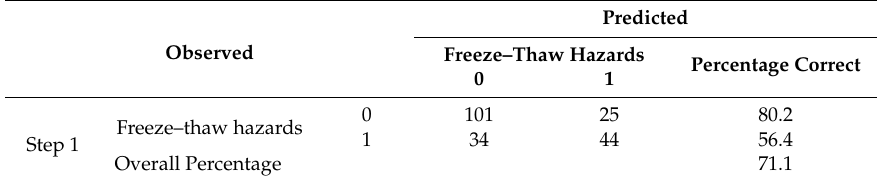
Table 2. Goodness-of-fit results for damage caused by frost heave and thawing settlement.